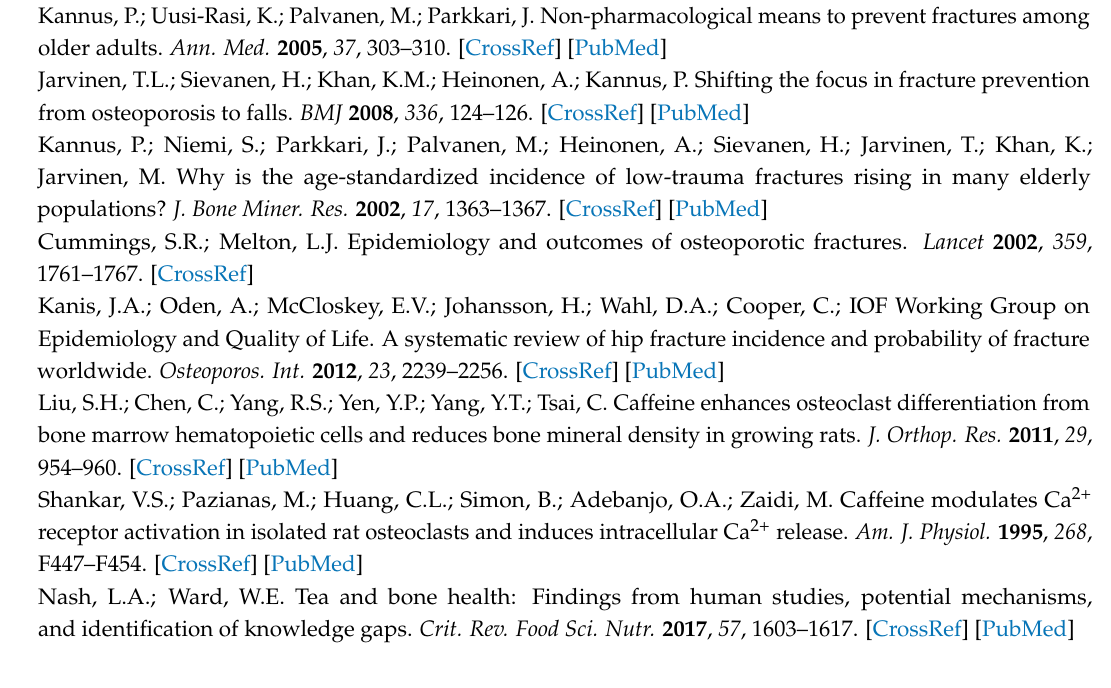
Table S1: Sex-specific HRs (95% CIs) for associations between tea consumption (in grams/day) and risk of fracture among 453,625 participants, Table S2: HRs (95% CIs) for associations of tea consumption (in cups/day) and risk of fracture among 453,625 participants, Table S3: Subgroup analyses of associations between tea consumption and risk of fracture according to types of tea and duration of tea consumption, Table S4: Subgroup analyses of associations between tea consumption and risk of fracture according to potential baseline risk